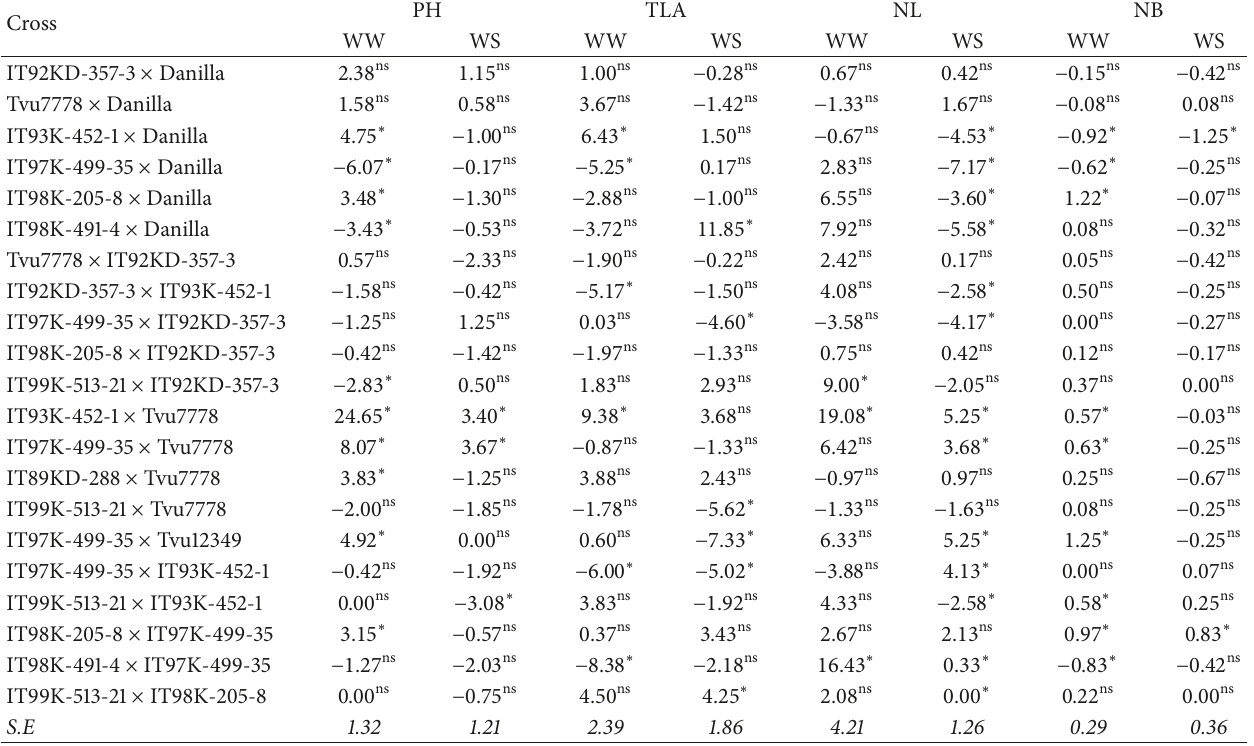
Table 5: Reciprocal combining ability effects for different morphological characteristics in cowpea in water-stressed (WS) and well-watered (WW)